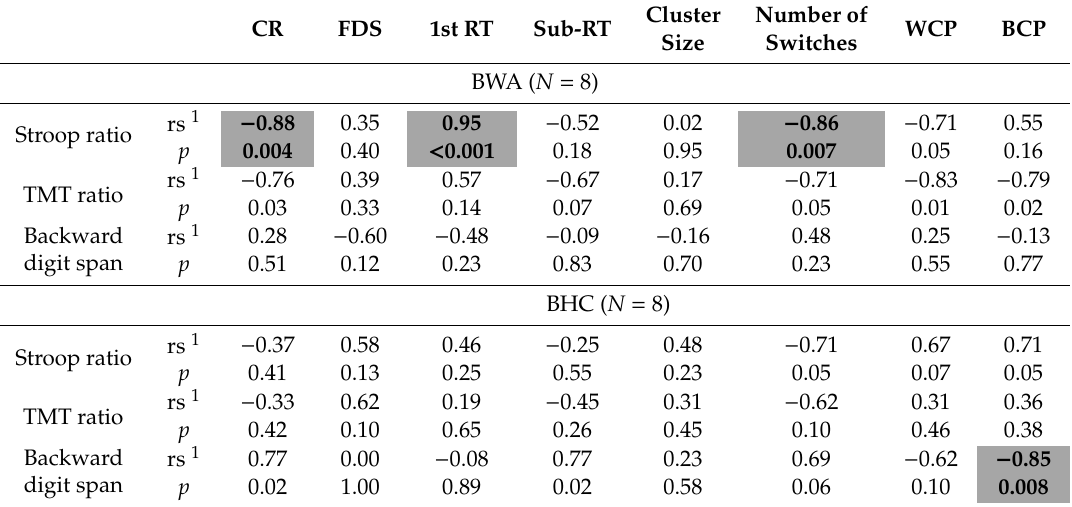
Table A4. Correlation coe ffi cients between the executive control measures and the verbal fluency variables for each